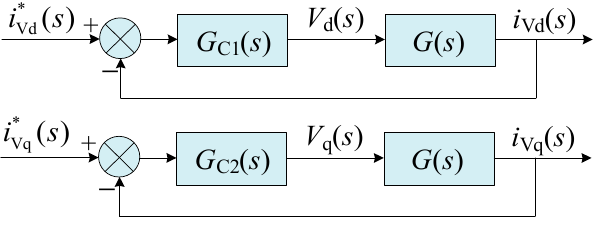
Figure 2. d-axis and q-axis closed-loop control system of output